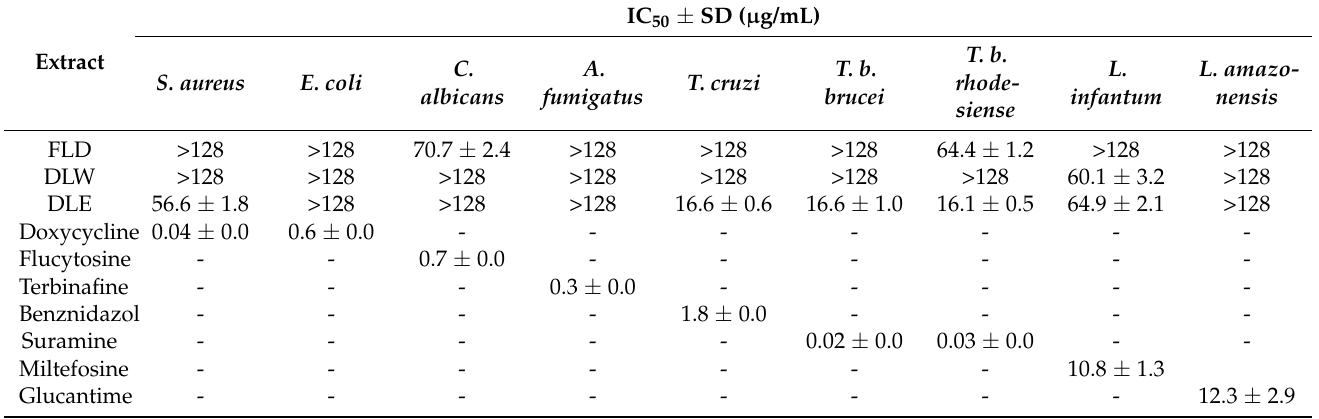
Table 4. Antimicrobial activity of extracts from Plectranthus neochilus leaves growing in Santiago de Cuba.